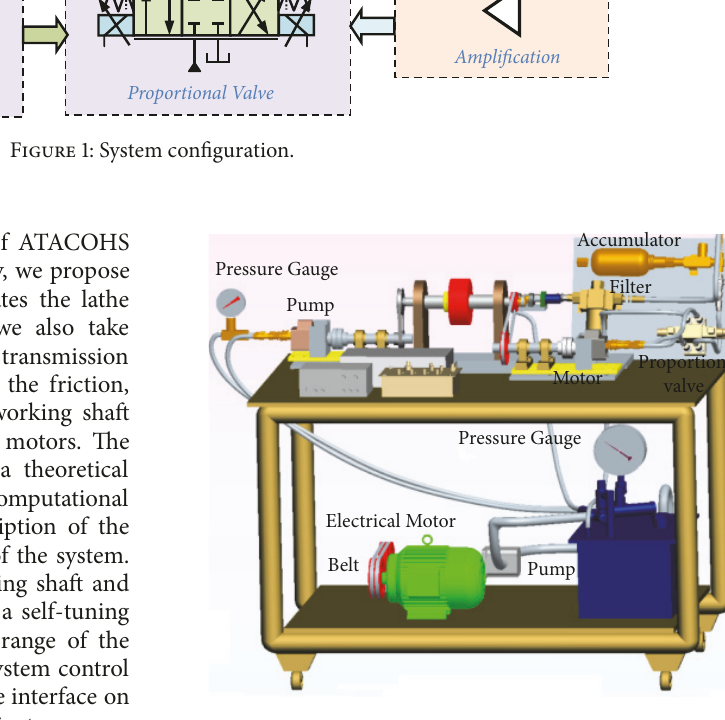
Figure 2: Experimental